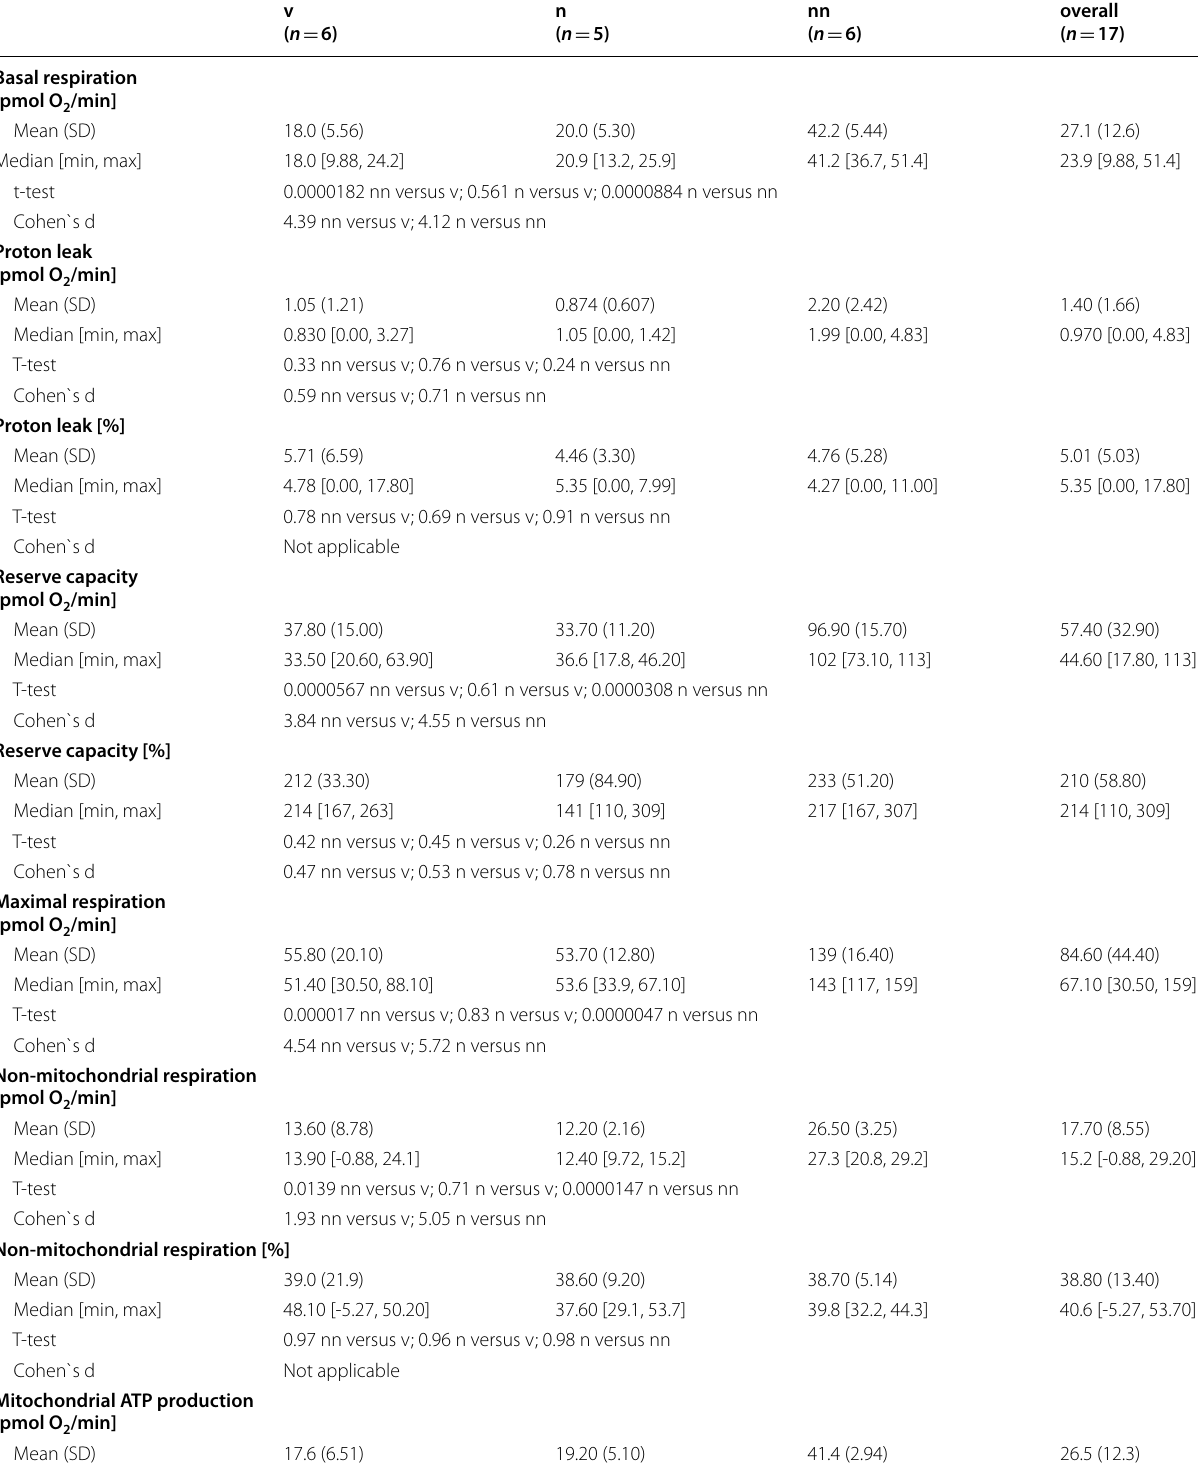
Table 2 Parameter of the Bioenergetic Health Index (BHI). The distinct parameter were taken before (v), after the first 10-pass OHT (n) and after the second 10-pass OHT one week later (nn). The data represent cumulative data from the respective subjects and are expressed as means s.e.m and as median. The statistics include the t-test and the Cohen`t d test + v n ( n 6) ( n = =